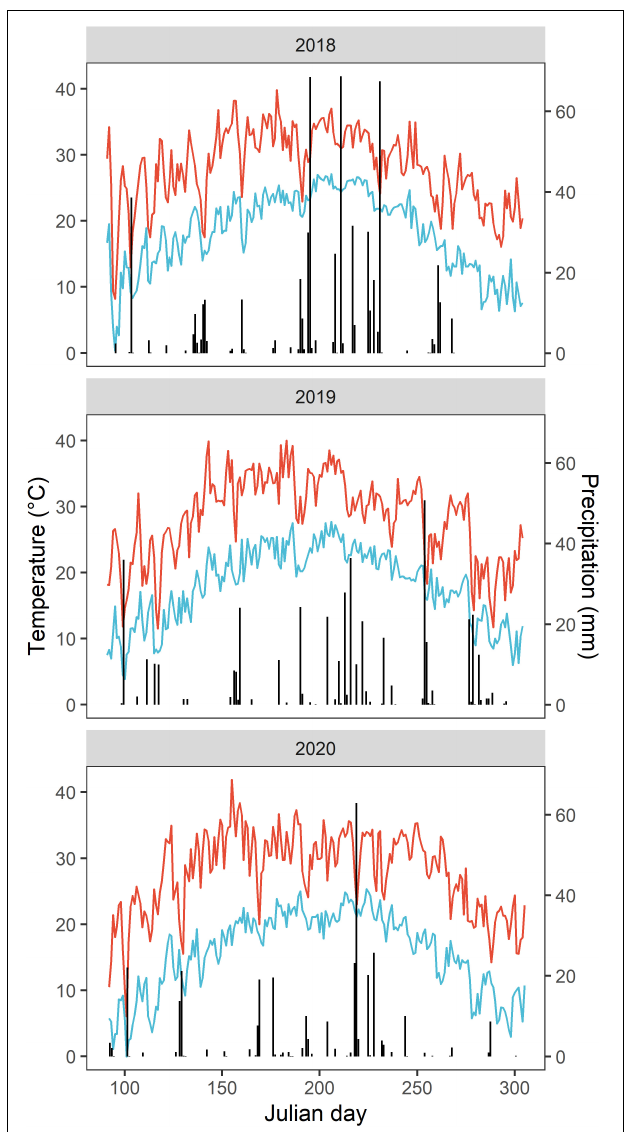
FIGURE 1 | Daily air temperature and precipitation during the cotton growing season from April to October in 2018–2020. The evolution of daily maximum and minimum temperature values are presented as continuous red and blue lines, respectively. The vertical bars depict daily